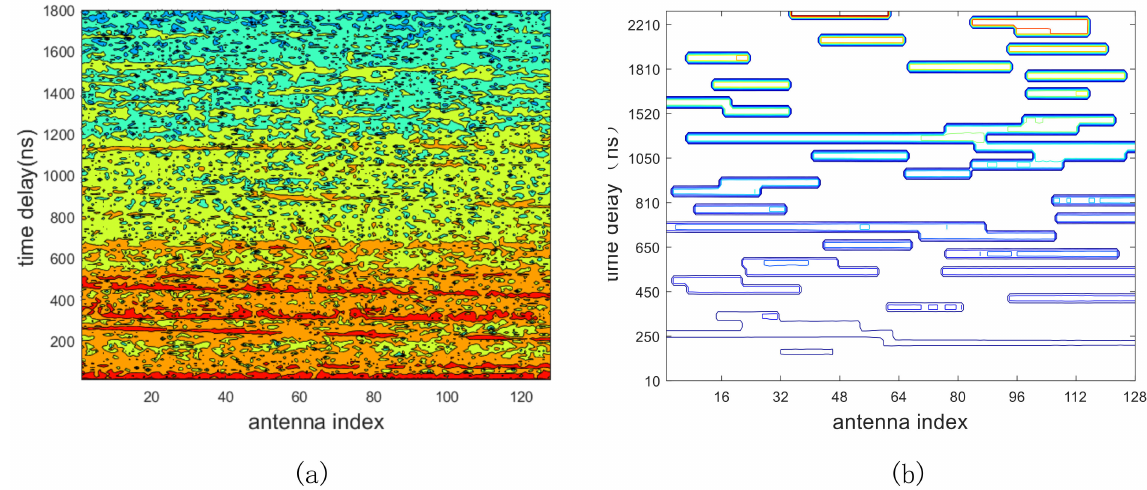
Figure 8. Cluster distribution over the antenna array axis. ( a ) The PDP over the antenna array; ( b ) multipath cluster distribution over the antenna array.